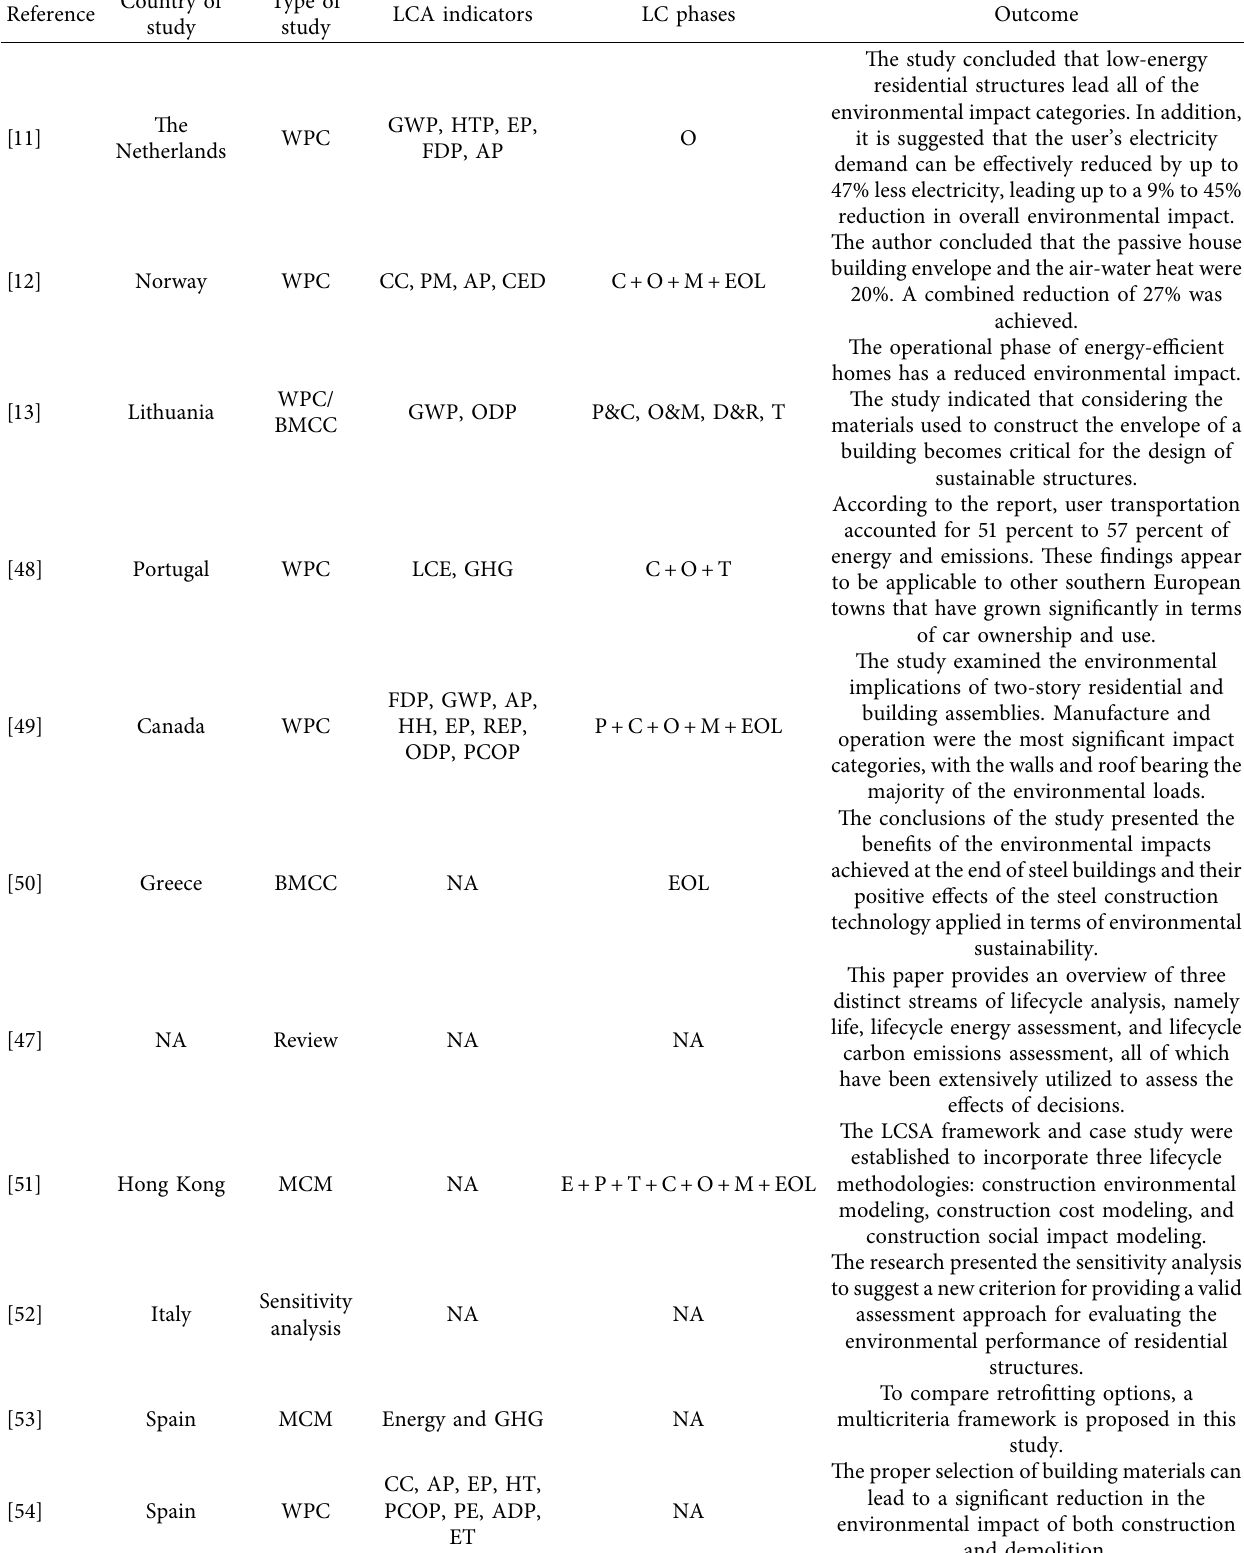
Table 2: Review of LCA from previous